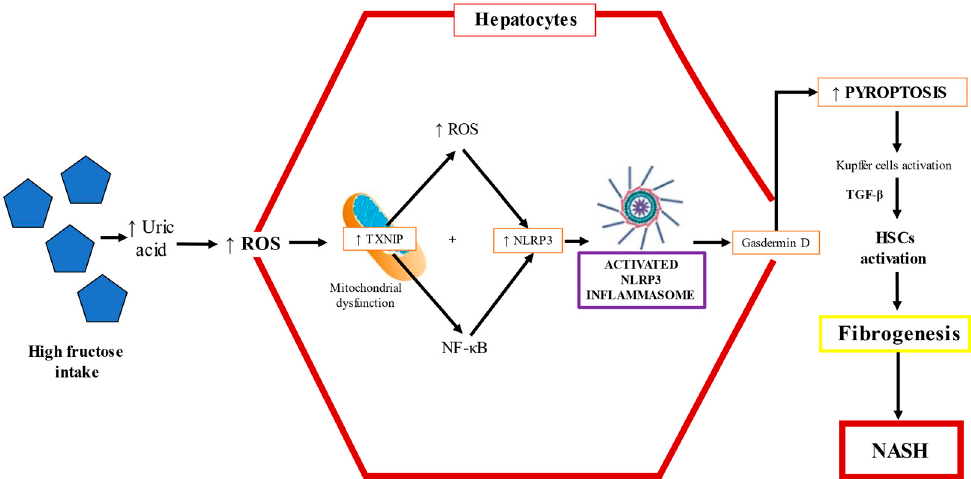
Figure 5. The fructose–pyroptosis axis. High fructose intake induces uric acid production in the intestine and liver, increasing reactive oxygen species (ROS). The resulting oxidative stress promotes the intracellular translocation of the thioredoxin-interacting protein (TXNIP) in the mitochondria; then, the interaction between TXNIP and NOD-like receptor family pyrin domain containing 3 (NLRP3) leads to NLRP3 inflammasome activation. The assembly of the inflammasome machinery enhances the pyroptosis of hepatocytes by the gasdermin D pathway and leads to the activation of Kupffer cells and transforming growth factor-beta (TGF- β ) secretion, which results in HSC activation, triggering fibrogenesis in nonalcoholic steatohepatitis (NASH).